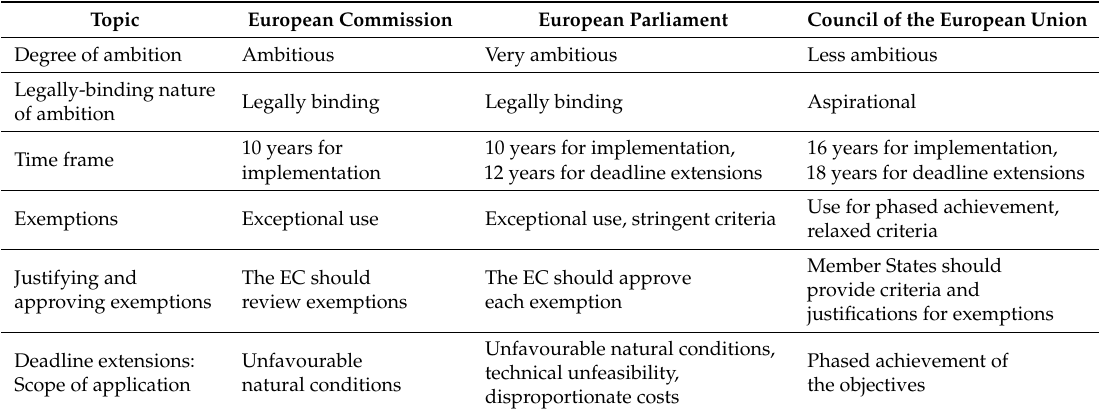
Table 1. Position of each institution during the